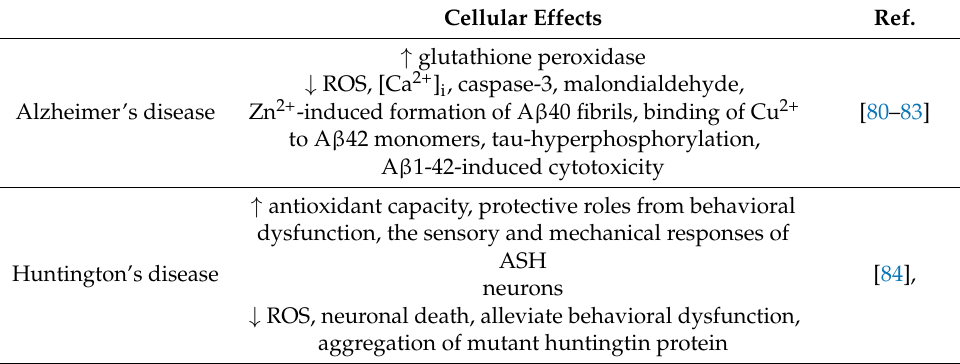
Table 2. Physiological effects of SeNPs on